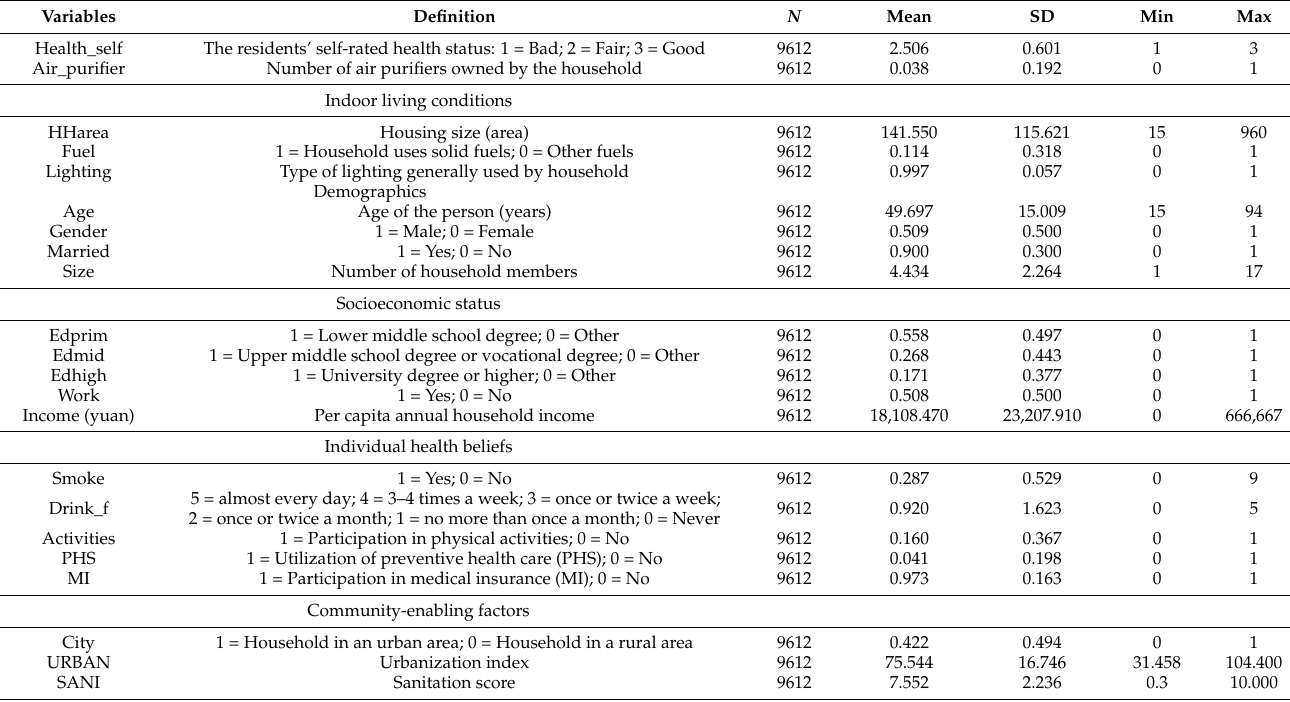
Table 1. Descriptive statistics of the